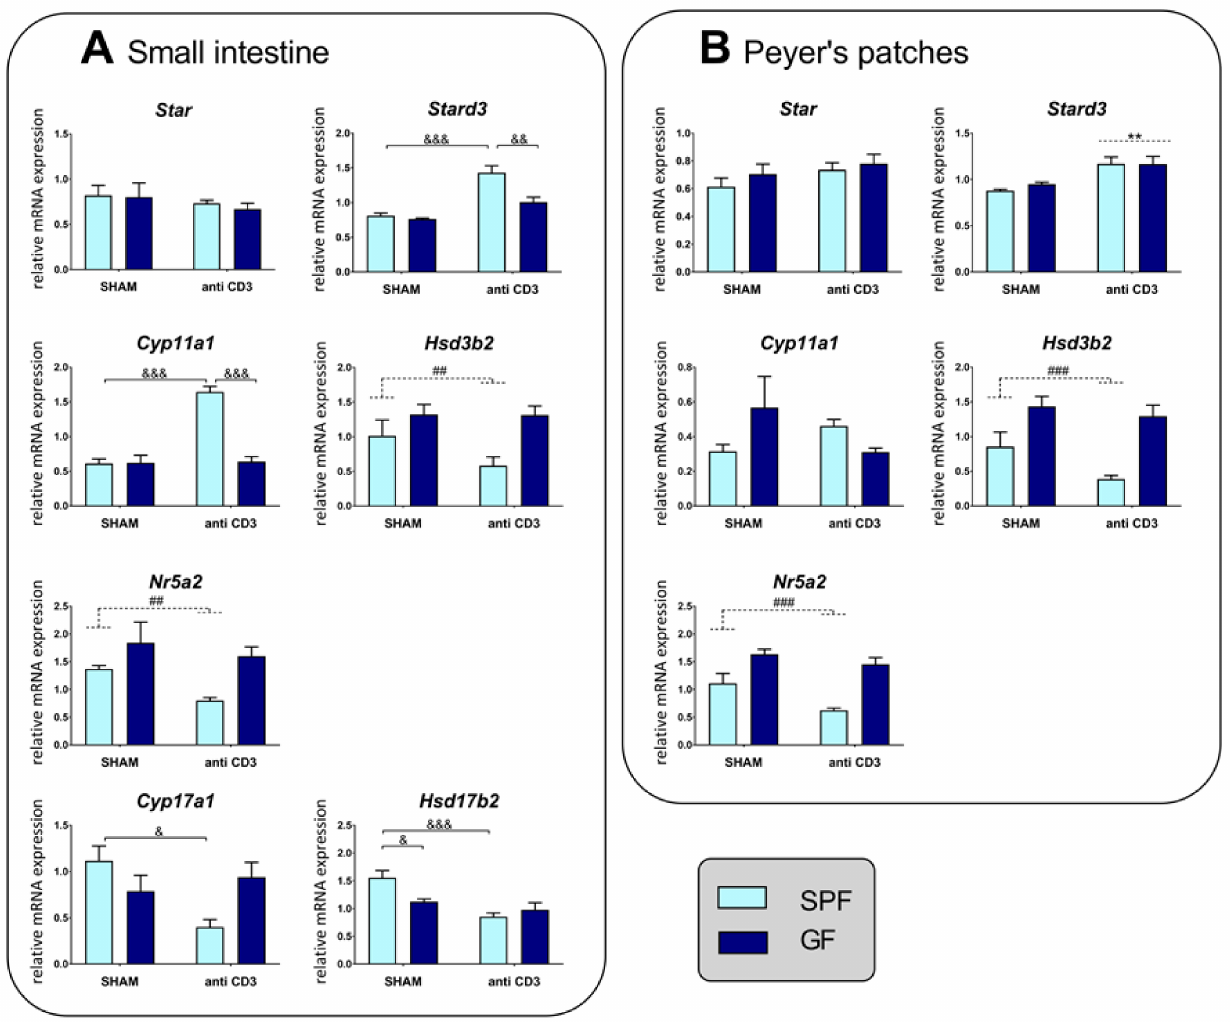
Figure 2. Effect of microbiota and acute immune stress on the expression of steroidogenic enzymes in the small intestine ( A ) and Peyer’s patches ( B ). The abundance of the mRNAs was determined in mice that were treated with the anti-CD3 antibody or saline 4 h beforehand. SPF, specific pathogen-free mice; GF, germ-free mice; SHAM, mice injected with saline; anti-CD3, mice injected with anti-CD3 antibody; Star, steroidogenic acute regulatory protein; Stard3 , functional homolog of Star ; Cyp11a1 , cholesterol side-chain cleavage enzyme; Hsd3b2 , 3 β -hydroxysteroid dehydrogenase type 2; Cyp17a1 , 17,20-desmolase; Hsd17b2 , 17 β -hydroxysteroid dehydrogenase type 2; Nrp5a2 , liver receptor homolog-1. The data are expressed as means ± SEM. Where an interaction effect was observed, the ampersand sign indicates a significant difference ( & p < 0.05, && p < 0.01, &&& p < 0.001). Where no interaction effect was observed, a main effect of microbiota has been marked by placing a dashed horizontal line with a hash sign ( ## p < 0.01, ### p < 0.001) above the bars for the SPF groups, whereas a main effect of stress has been marked by placing a dashed horizontal line with an asterisk (** p < 0.01) above the bars for the stress-exposed